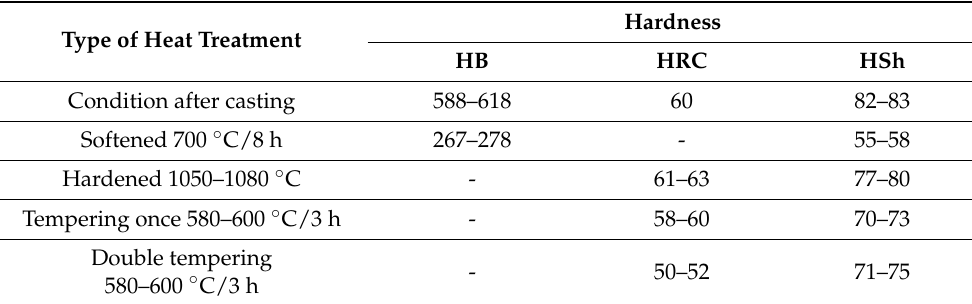
Table 4. Results of hardness measurements of HSS